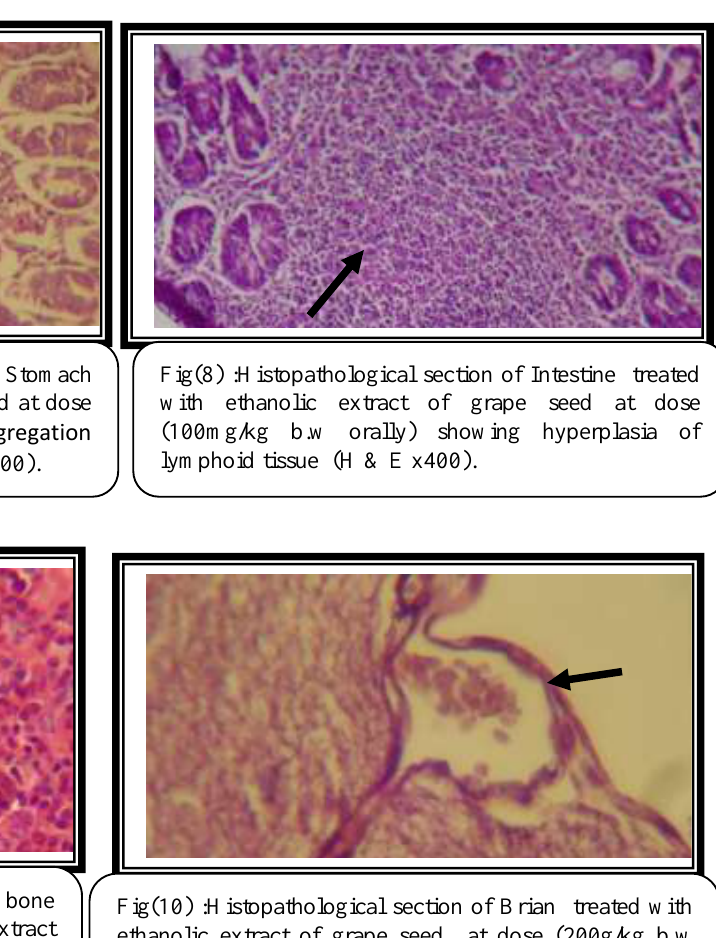
Fig(10) :Histopathological section of Brian treated with ethanolic extract of grape seed at dose (200g/kg b.w orally) showing severe congestion of blood vesscls of cerebellar meninges (H & E x400).